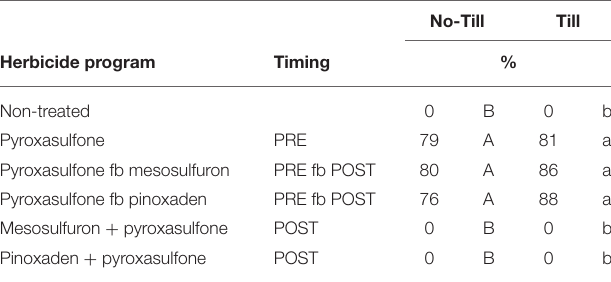
TABLE 2 | Italian ryegrass control at the postemergence timing in winter wheat averaged across locations (Hertford and Salisbury, North Carolina) and years (2013 and 2014); experiments were separated by tillage environment.